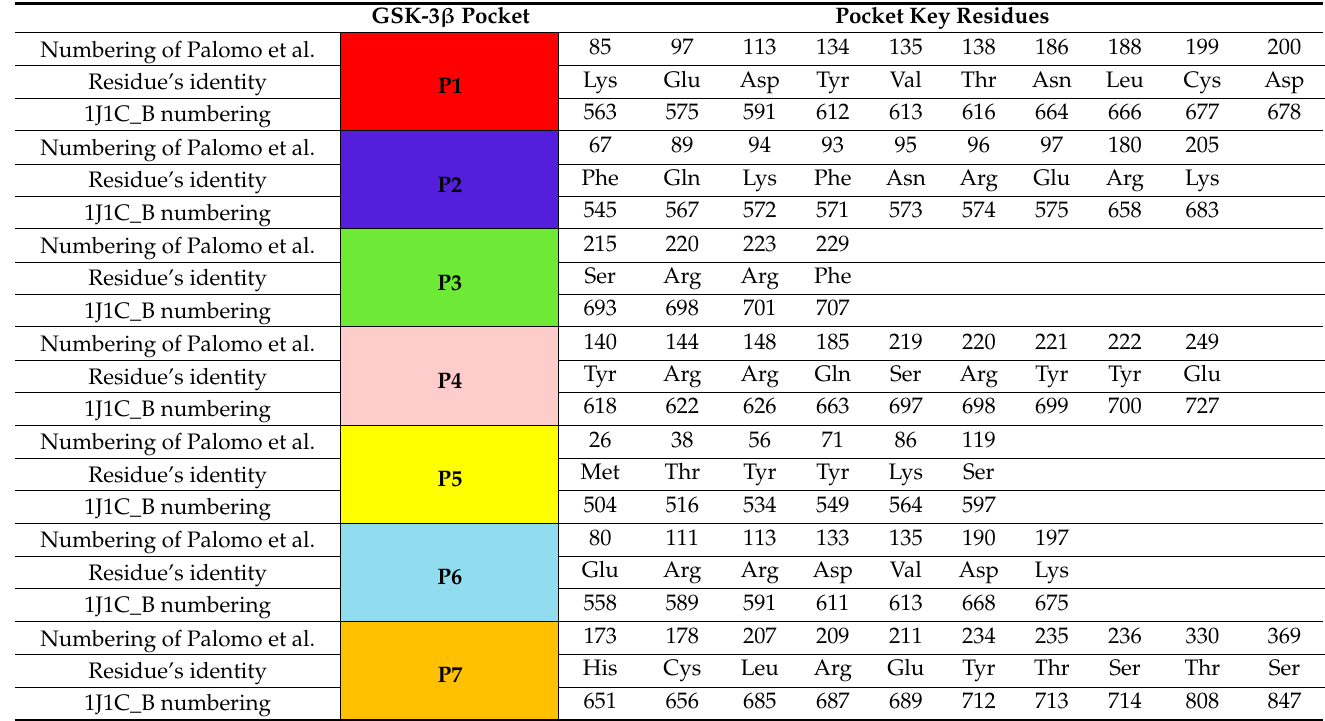
Table 1. Key residues of the main GSK-3 β pockets (indicated as P1–P7), as described in Palomo et